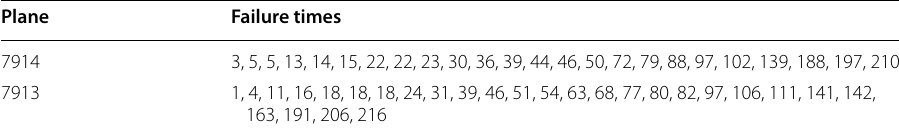
Table 1 Failure times of air-conditioning systems in two airplanes